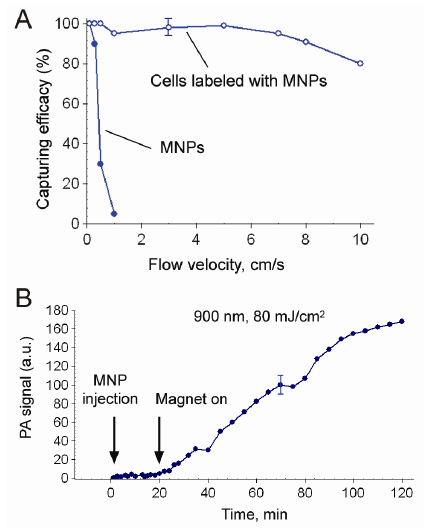
Figure 18. ( A ) Capturing efficiency for MNP-labeled cancer cells and free MNPs at different flow velocity of PBS in tube with diameter of 0.5 mm; ( B ) PA signals from CTCs in 200–300 µm abdominal mouse skin vessels obtained with fiber schematics at week one tumor development before and after magnet action